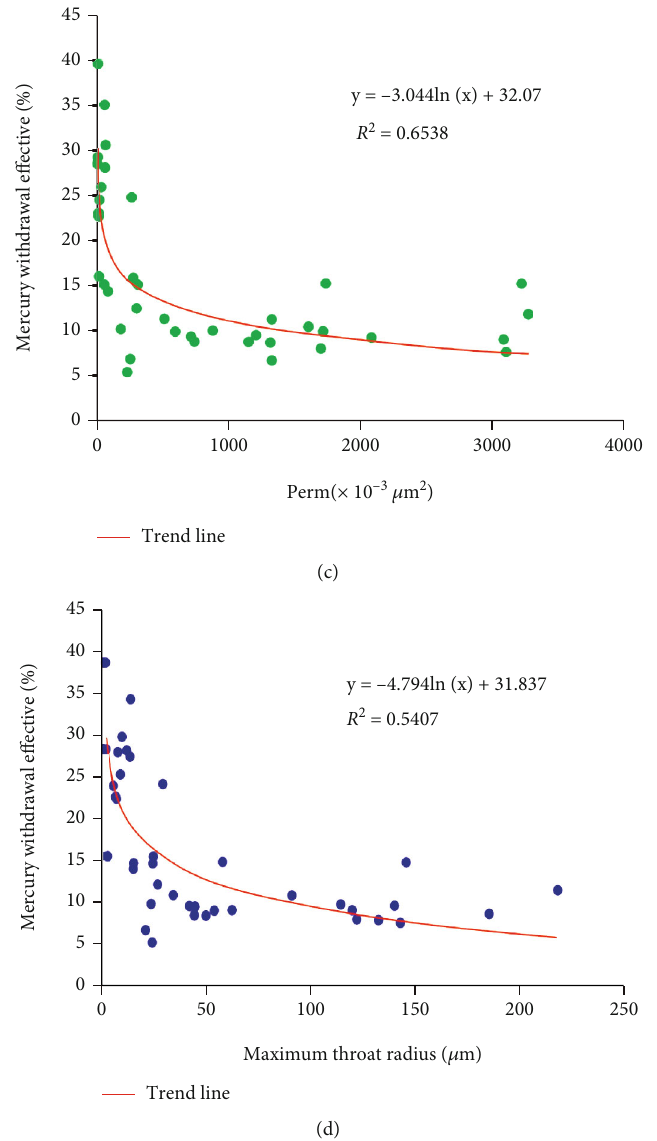
Figure 6: Scatter diagram of core porosity, permeability, and mercury withdrawal e ffi ciency from the TIII reservoir in Sangtamu Oil fi eld. Table 1: Core physical properties of the TIII reservoir with di ff erent seepage capacities in Sangtamu Oil fi eld. Well name